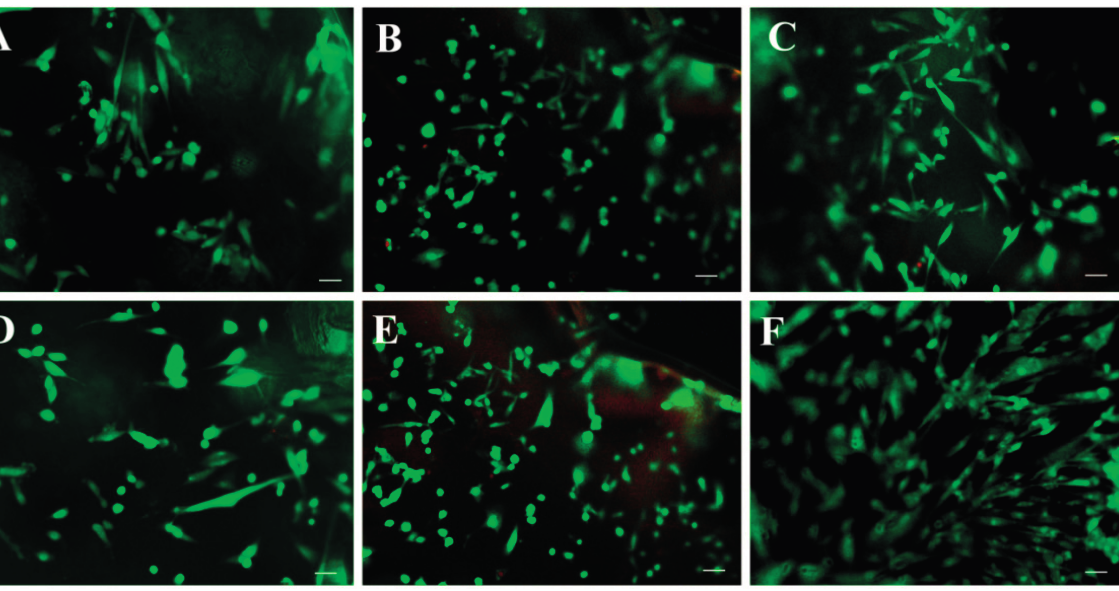
Figure 6. Live dead assay of HDFs on ( A , D ), Chitin ( B , E ), Chitin/PBS ( C , F ), Chitin/PBS/CSnps after 24 h ( A – C ), and 48 h ( D – F ). Scale bar denotes 50 μ m.